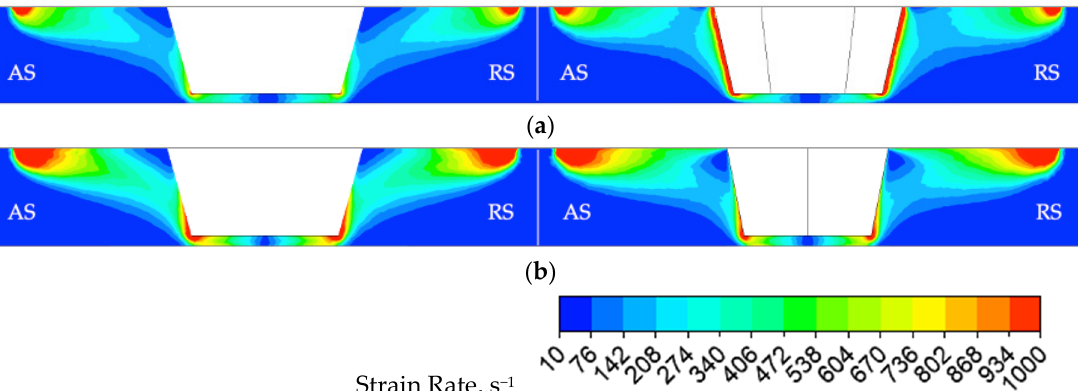
Figure 11. The distribution of the strain rate for both FSW − C ( left ) and FSW − H ( right ) samples: ( a ) transverse and ( b )